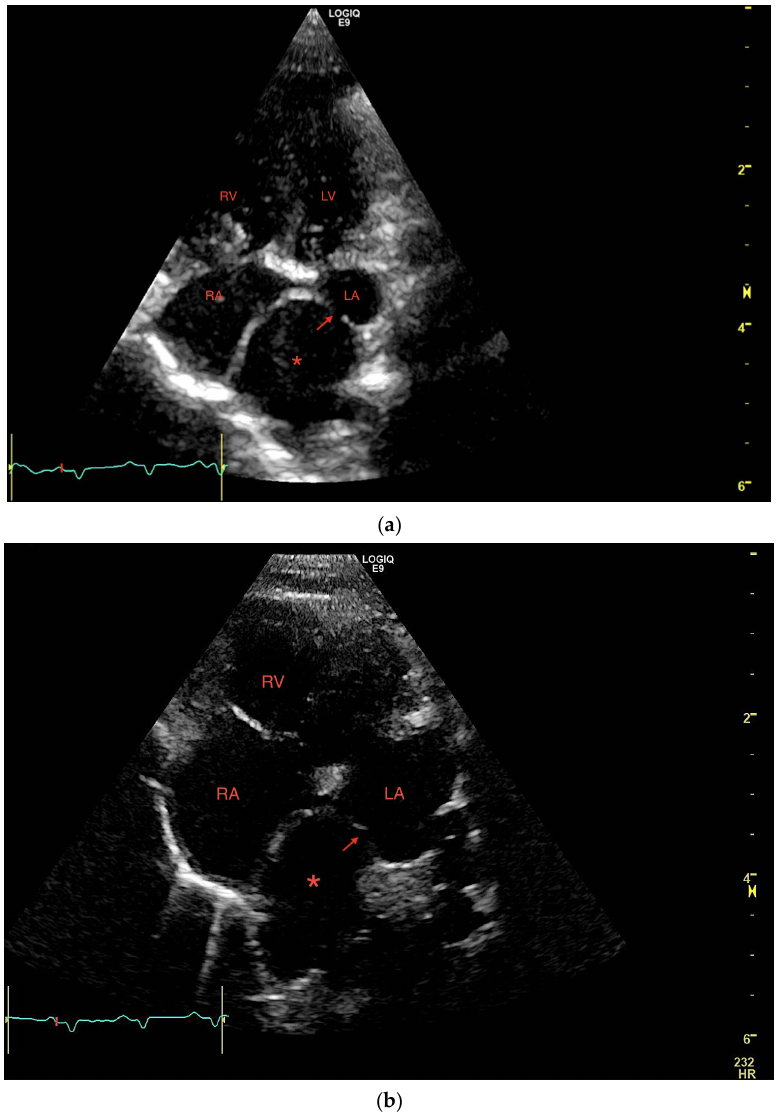
Figure 2. ( a , b ) Transthoracic left apical window modified 4-chamber optimized for showing the dilated PV (red *) opening into the LA through a narrow ostium at the PV-LA junction (red arrow). LA: left atrium, PV: pulmonary vein, RA: right atrium, RV: right